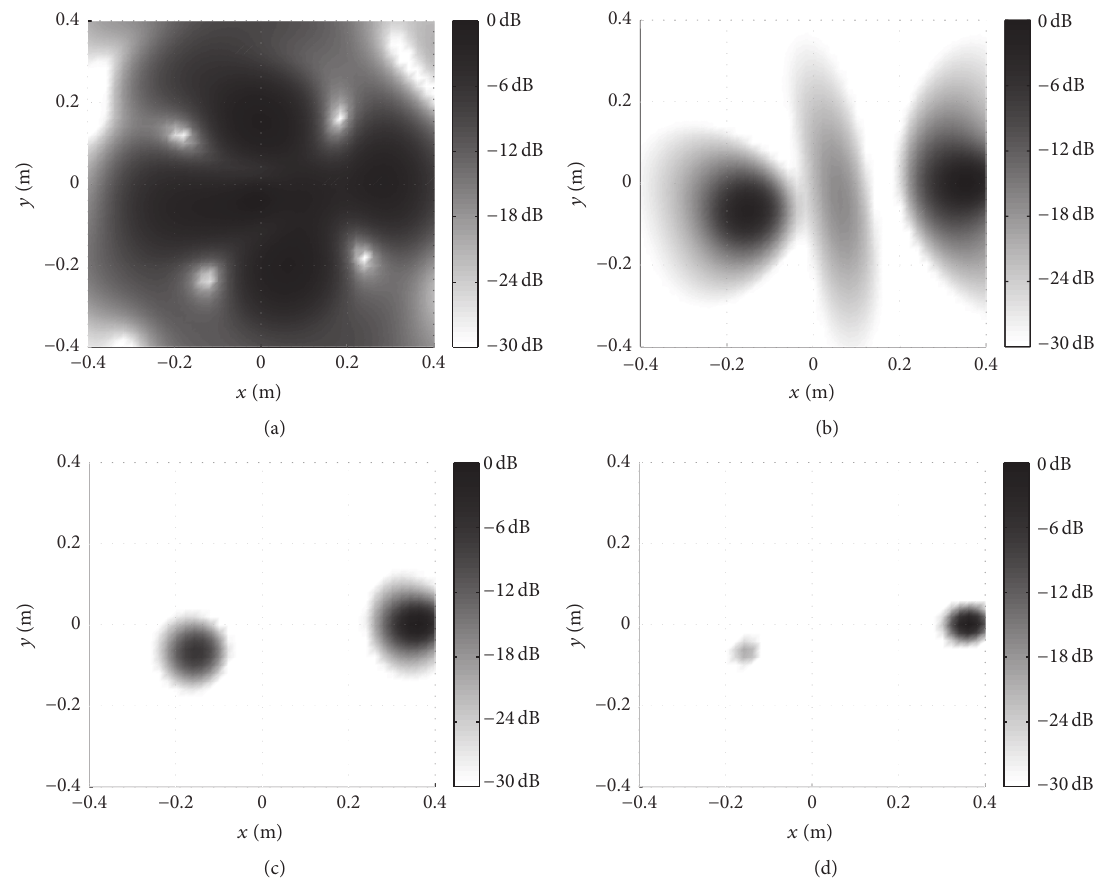
Figure 11: Noise source maps for two coherent sound sources (800 Hz). (a) WBH. (b) iWBH. (c) IFESM, V = 2 . (d) IFESM, V = 4